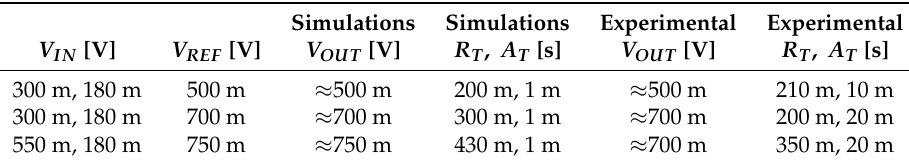
Table 2. Analog AGC experimental result.